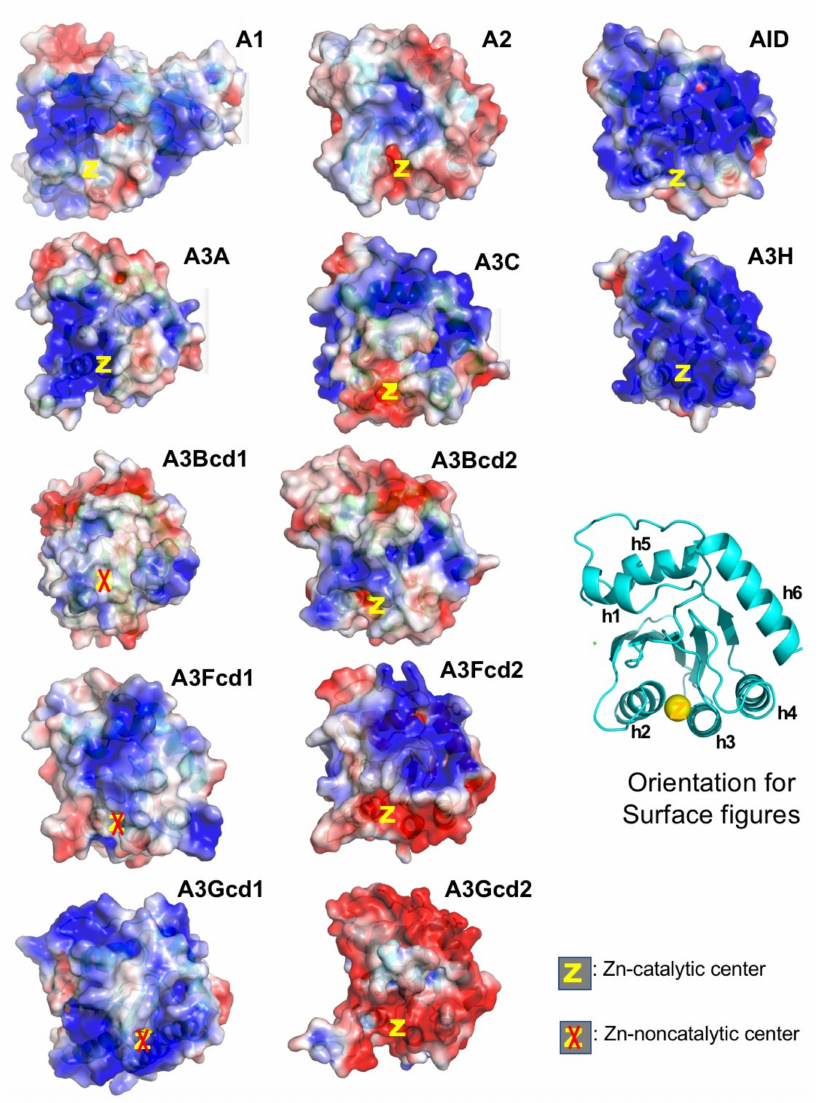
Figure 4. Surface charge of APOBECs CD domains. The general orientation for all panels is shown as the ribbon structure. Among all catalytic CD domains (not including CD1 of A3s), only A3A and A3H have their Zn-center embedded within positively charged surfaces (PCS, in blue). A2 and A3Gcd2 have the least PCS among single-domain and double-domain APOBECs, respectively. It is worth noting that A2, A3Gcd2, and A3A are the only three proteins that do not form large RNA-bound multimeric forms in cell lysates (data not shown). Note: A3Fcd1 structure is to be published structure. PDBids for other structures are A1, 6X91; A2-core, 2nyt; AID, 5W1C; A3A, 5KEG; A3C, 3VOW; A3H, 5W3V; A3Bcd1, 5TKM; A3Bcd2, 5CQI; A3Fcd2, 3WUS; A3Gcd1, 5K83; A3Gcd2,